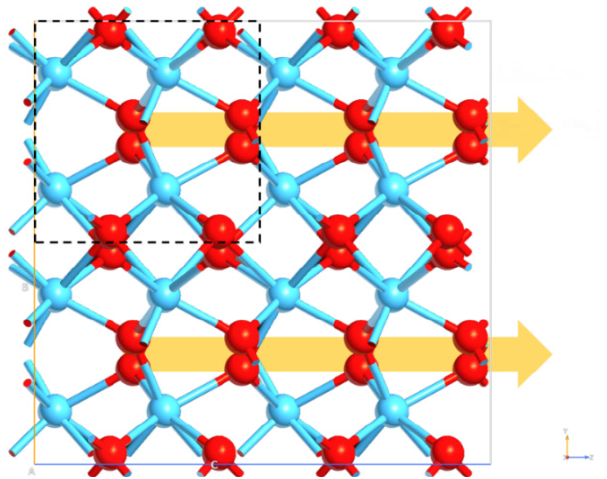
Figure 9. Orthorhombic phase of HfO 2 . Hf and O entities are reported in light blue and red respectively. The dashed square shows the o-unit cell. The yellow arrows highlight the polarization direction.